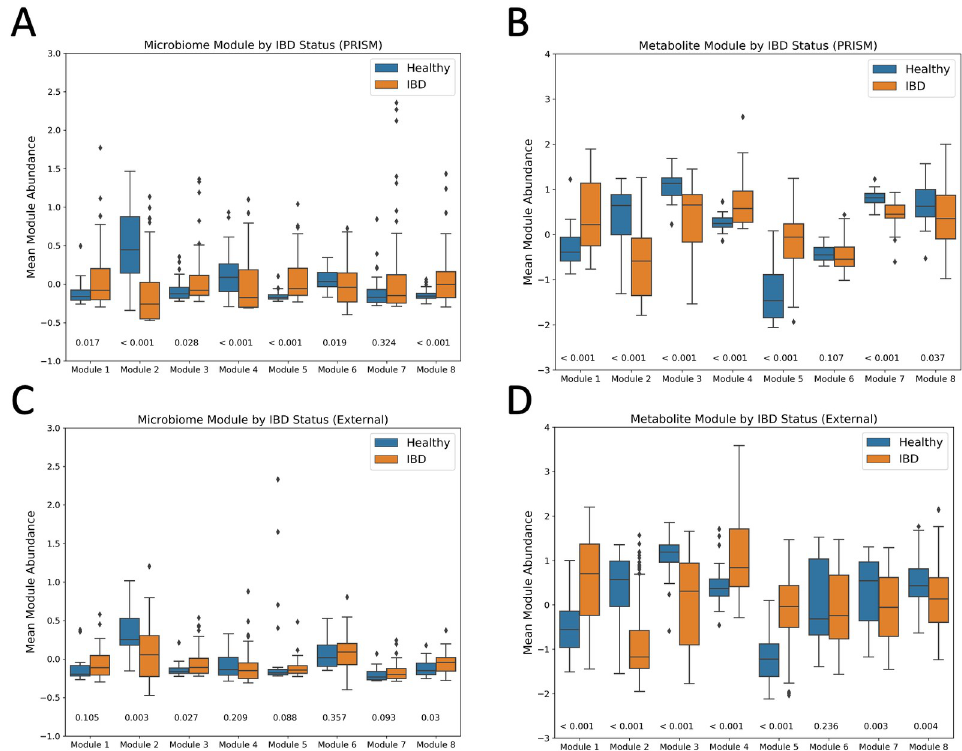
Fig 6. Microbial and metabolic module abundance by patient status in the IBD (PRISM) dataset. The mean normalized abundance of members within modules are shown here for healthy patients and IBD patients from the IBD (PRISM) dataset using (A) microbial and (B) metabolic modules and from the IBD (External) dataset using (C) microbial and (D) metabolic modules identified by MiMeNet. P-values from a two-sided Wilcoxon rank-sum test are shown on the